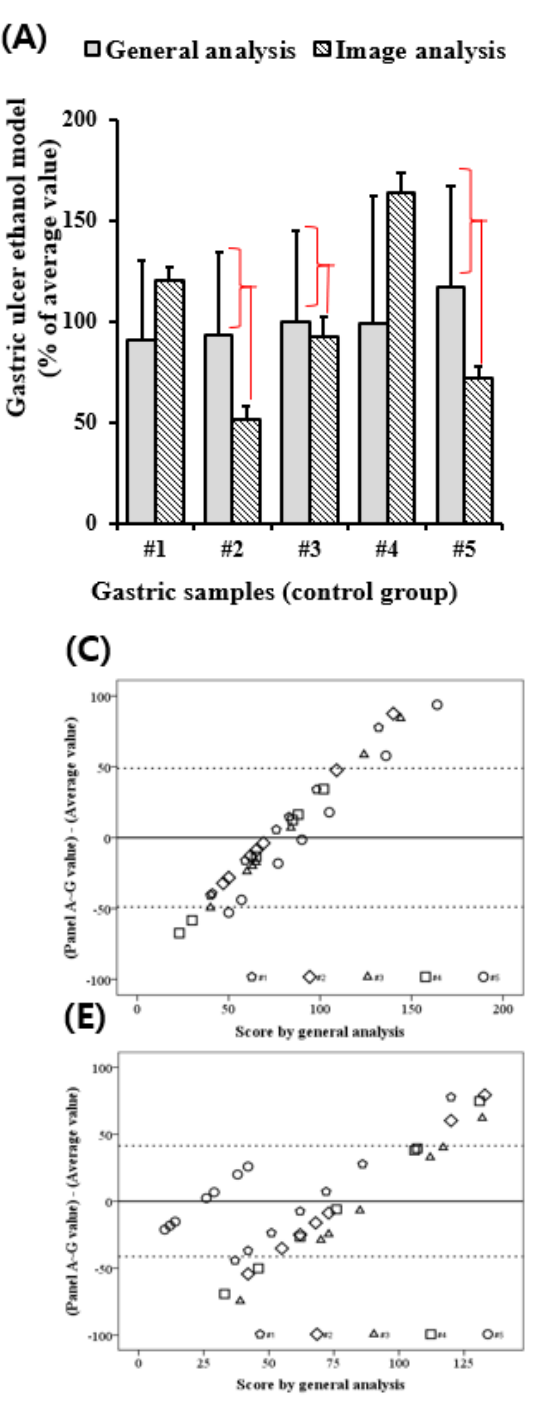
Figure 3. Comparison of gastric ulcer scores observed by CCO and IA. ( A , B ) The SD bar indicates the differences among the eight professionals for individual mouse ulcers. To compare the reproducibility according to the same object and different panels, a Bland–Altman plot was created. The y-axis